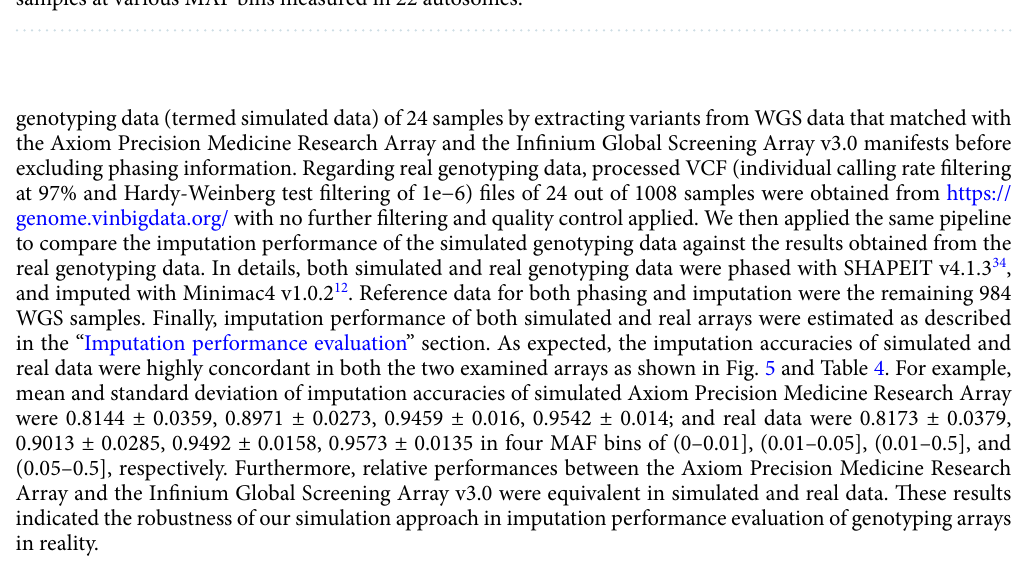
Table 4. Mean and the standard deviation of imputation accuracies of simulated and real data of the Axiom Precision Medicine Research Array (PMRA) and the Infinium Global Screening Array v3.0 (GSA) of 24 VNP samples at various MAF bins measured in 22